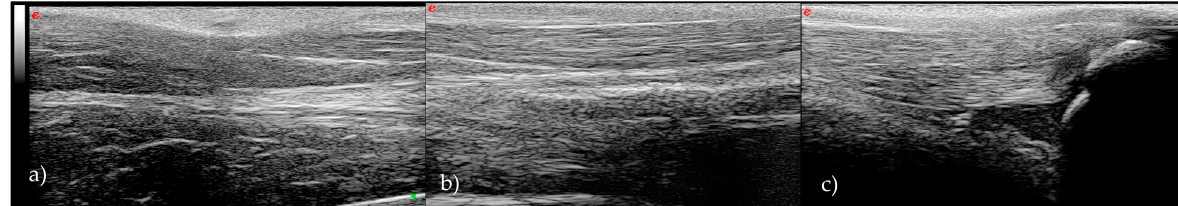
Figure 1. Longitudinal ultrasonographic scan of the normal ovine common calcaneal tendon (CCT): ( a ) myotendinous junction, ( b ) middle part and ( c ) insertion on the calcaneal tuberosity. In the transverse plane, the peritenon of the superficial digital flexor tendon and gas- trocnemius appeared as a hyperechoic line with the tendon fibers characterized by a punc- tiform hyperechoic texture (Figure 2).